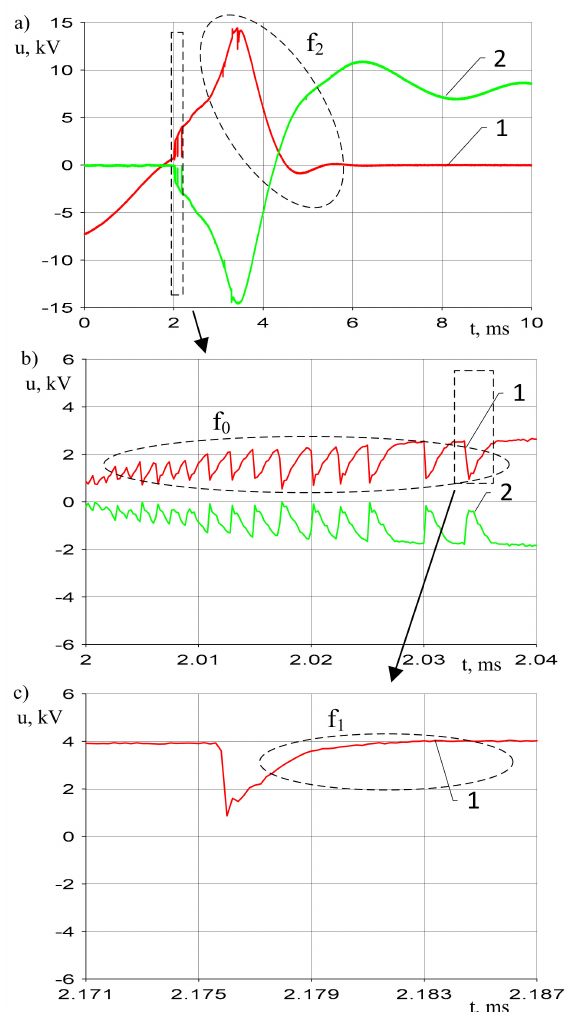
Figure 7. Transient phase voltage waveforms at transformer terminals Tr, switched off with a vacuum circuit breaker wb, connected to the transformer by 2 m long line lc in a single-phase system and voltage between the circuit breaker contacts wb (Figure 3): ( a ) — voltage waveforms in 10 ms time window; ( b , c ) — fragments of the diagram in Figure 7a: 1 — phase voltage across the transformer Tr, 2 — voltage between the contacts of the vacuum circuit-breaker wb.